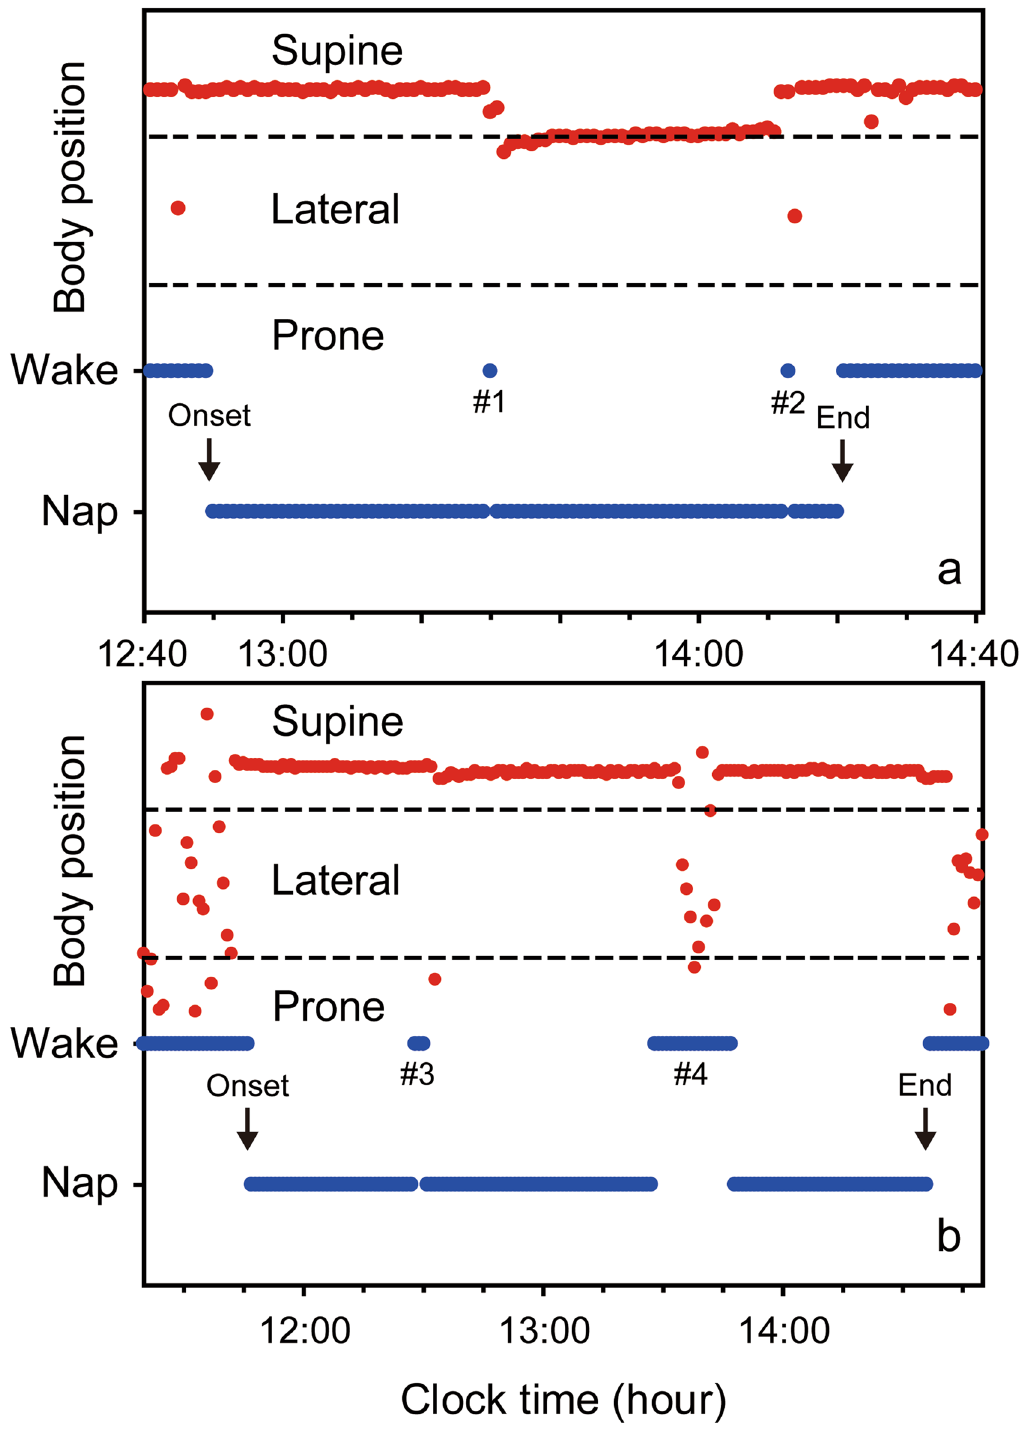
Figure 1. Representative daily activity-rest patterns of toddlers between 1 and 2 years of age during naps. The arrows indicate nap onset and end time, respectively. ( a ) After the toddler had transient wake #1 during nap, she had small body positioning changes within the supine position range and soon returned to sleep. After she had transient wake #2, she changed her body position from supine to lateral but soon returned to supine herself and went back to sleep smoothly. ( b ) After the toddler had transient wake #3 during nap, he changed his body position from supine to prone, leading to a forced postural change from prone to supine by a nursery staff member. Please note that he returned to sleep without any wake bout after the postural change. When he had another transient wake (wake #4), he again changed his body position from supine to prone and a nursery staff member returned his body position from prone to supine. However, he again changed his body position from supine to lateral and finally returned to supine himself and went back to sleep